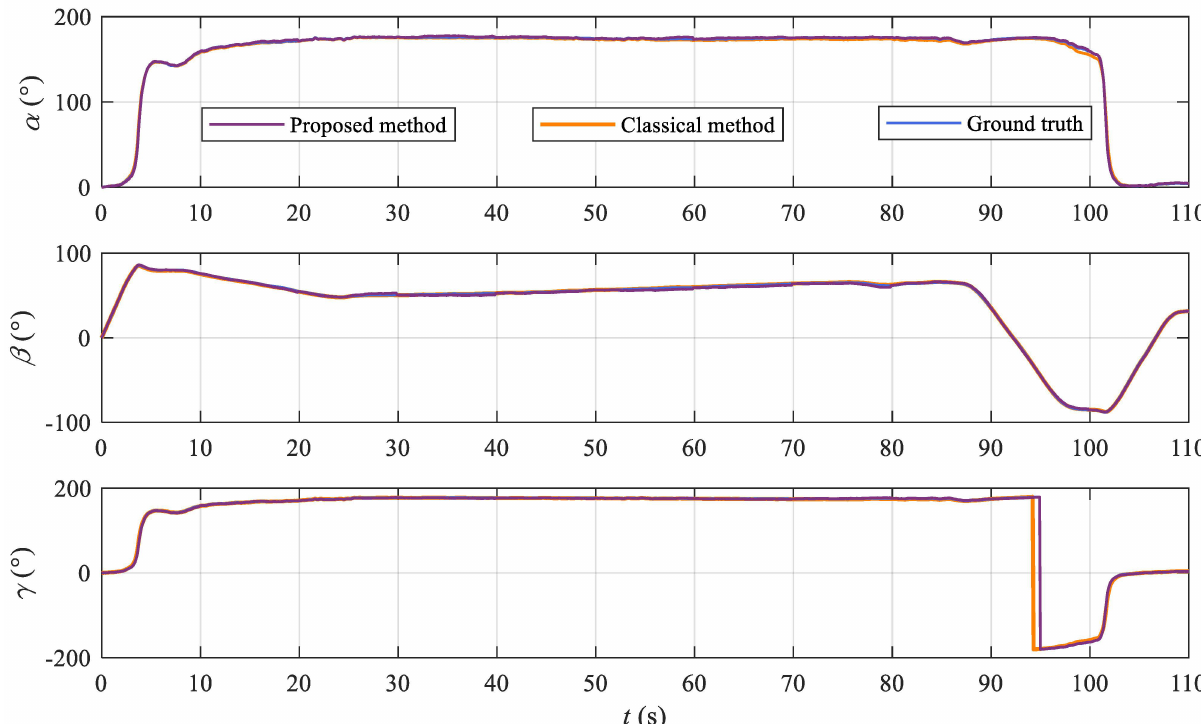
Figure 4. Attitude results of the classical method, the proposed method, and ground truth.